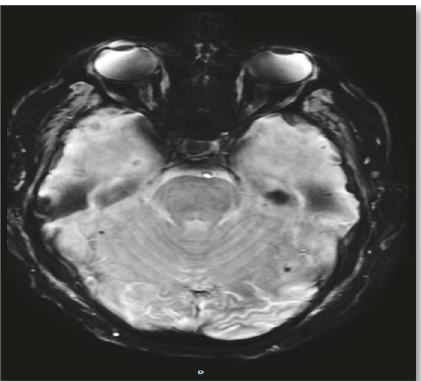
Figure 5: Periictal brain MRI SWAN image: showing gyriform hyperintense signal abnormality over bilateral occipital cortex. Abbreviations: MRI, magnetic resonance imaging; SWAN, suscep- tibility weighted angiography.